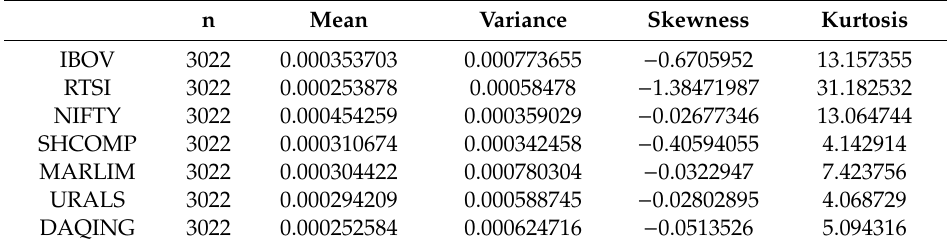
Table 1. Descriptive statistics for logarithmic returns of Brazil, Russia, India and China (BRIC) indexes and oil mixes. High kurtosis values appeared in every data series distribution. Source: own elaboration with data from